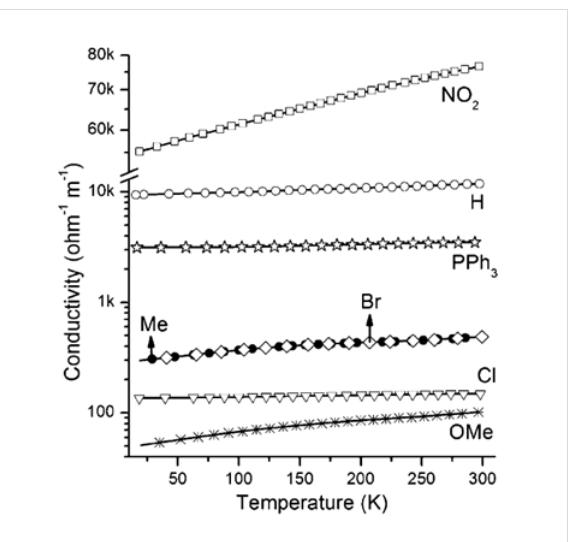
Figure 5: Conductivity as a function of the temperature in films of gold nanoparticles functionalized with thiophenol (H), with thiophenol para - substituted with nitro (NO 2 ), methyl (Me), bromine (Br), chloride (Cl), or methoxy (MeO) groups, and with triphenylphosphine (PPh 3 ). Reprinted with permission from [114], copyright 2012 American Chemical